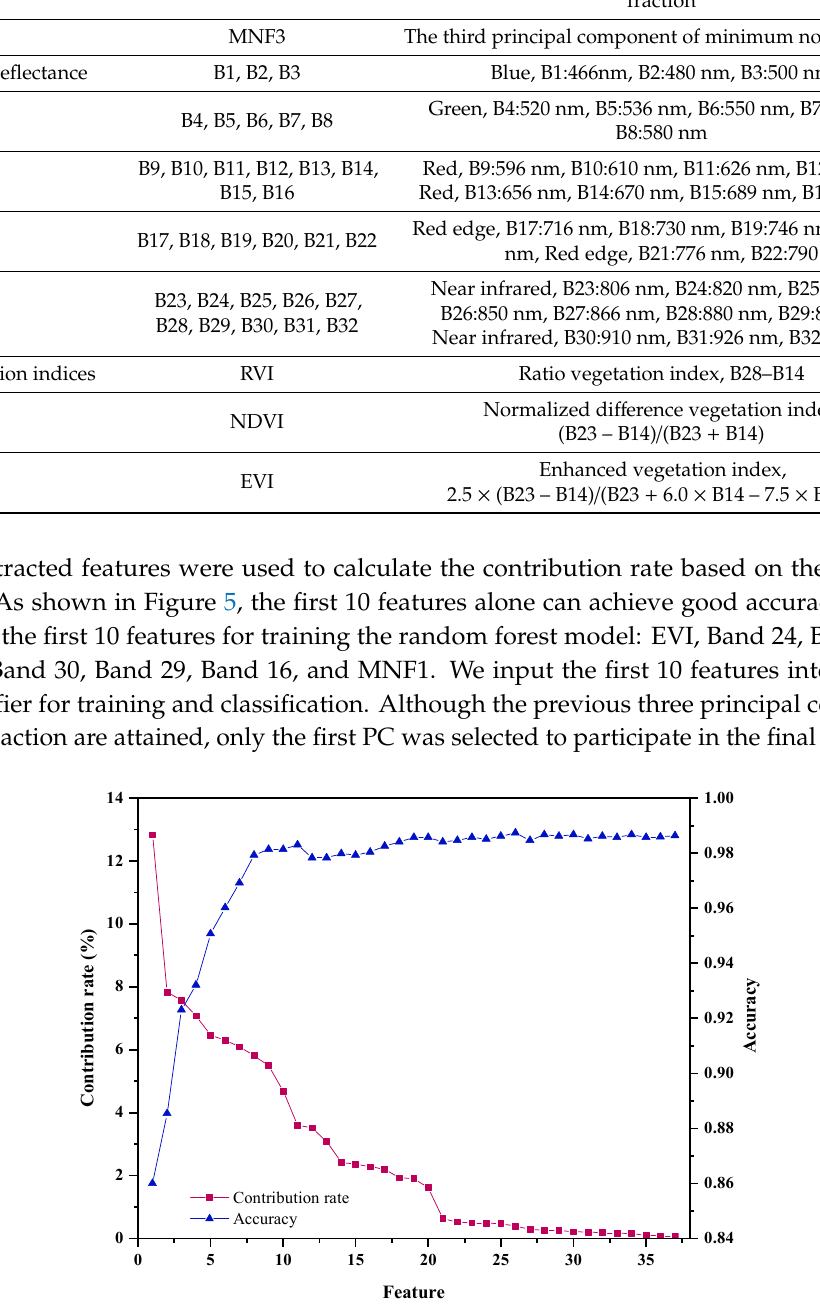
Table 2. Remote sensing indices from OHS-1 hyperspectral data for features extraction.